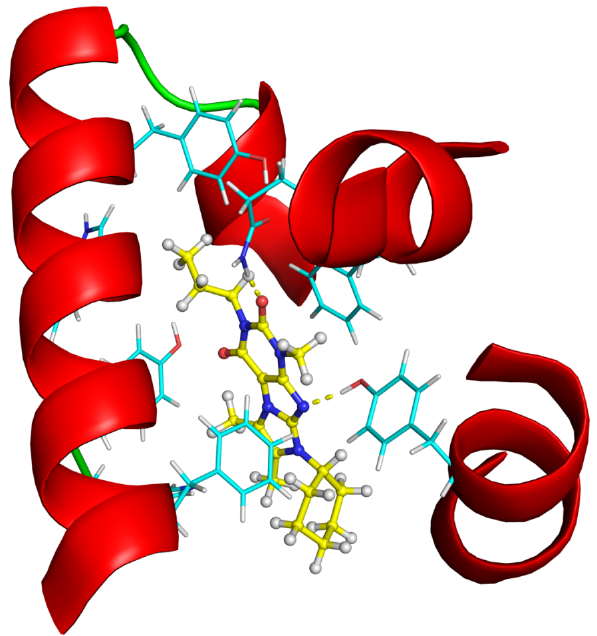
Figure 11. The structure of the Glide XP calculated PDE4B—#2 (2nd round hit) complex. Ligand carbon atoms are marked in yellow, while the nearest interacting protein residue side chains are shown in cyan color. The yellow dotted lines represent inter-molecular hydrogen